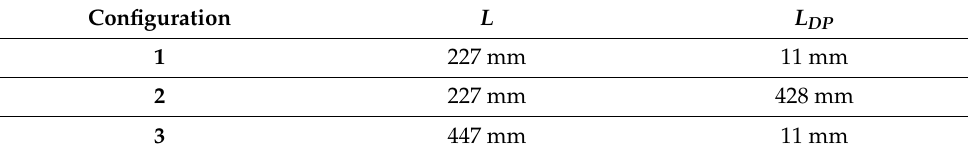
Table 1. Geometrical characteristics for the different flowmeter